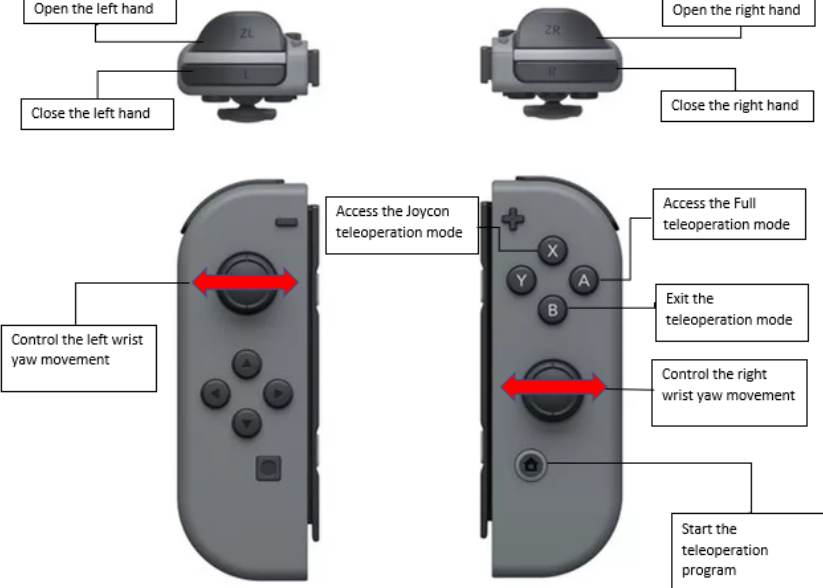
Figure 10. Button disposition of the